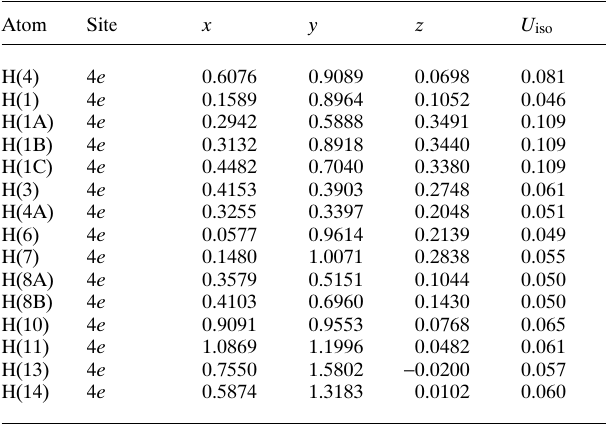
Table 2. Atomic coordinates and displacement parameters (in Å 2 )